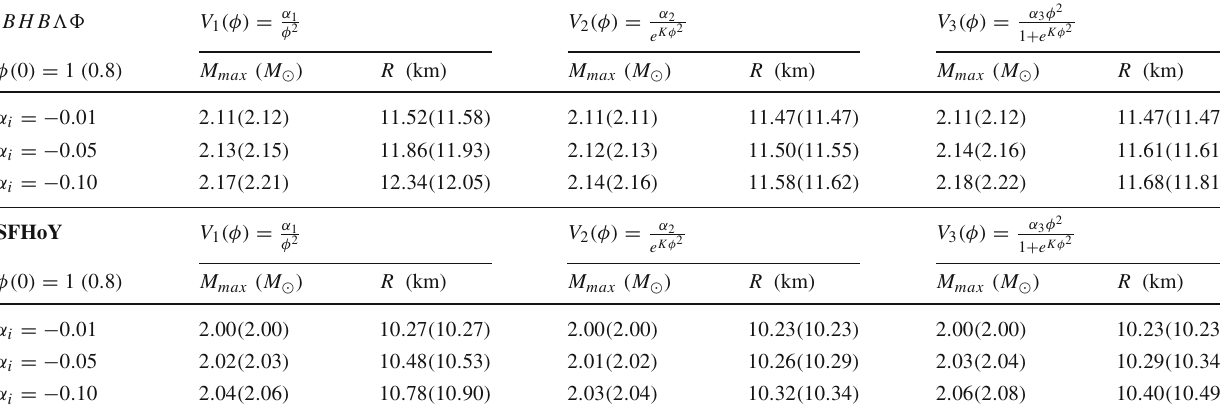
Table 4 M max and corresponding radius for hadronic EoSs with K = 0 . 5, φ( 0 ) = 1 (φ( 0 ) = 0 . 8 ) and various α i ( i = 1 .. 3 ) BH B (cid:7)(cid:8)